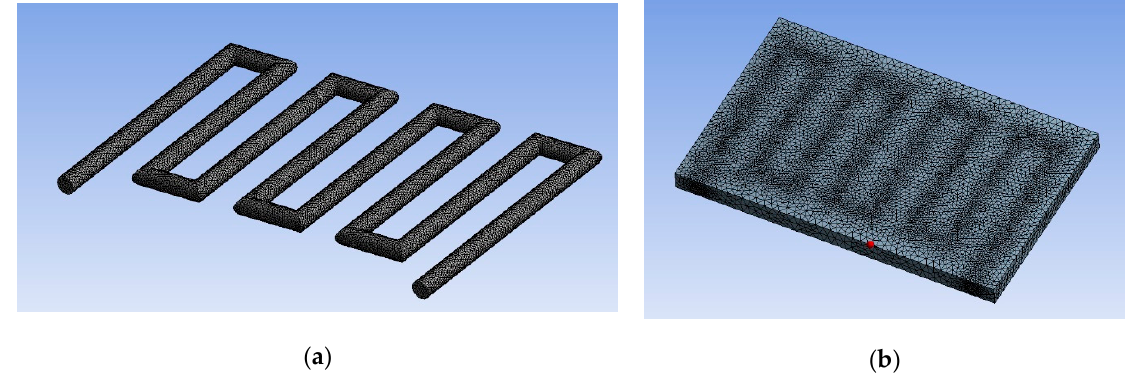
Figure 2. The meshing design of cold plate. ( a ) Internal meshing; ( b ) Overall meshing.